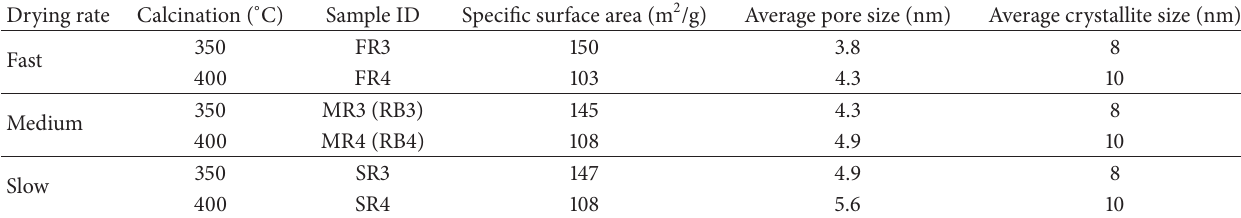
Table 2: Specific surface area, average pore size, and average crystallite size of mesoporous titania samples with different drying rate in rotary